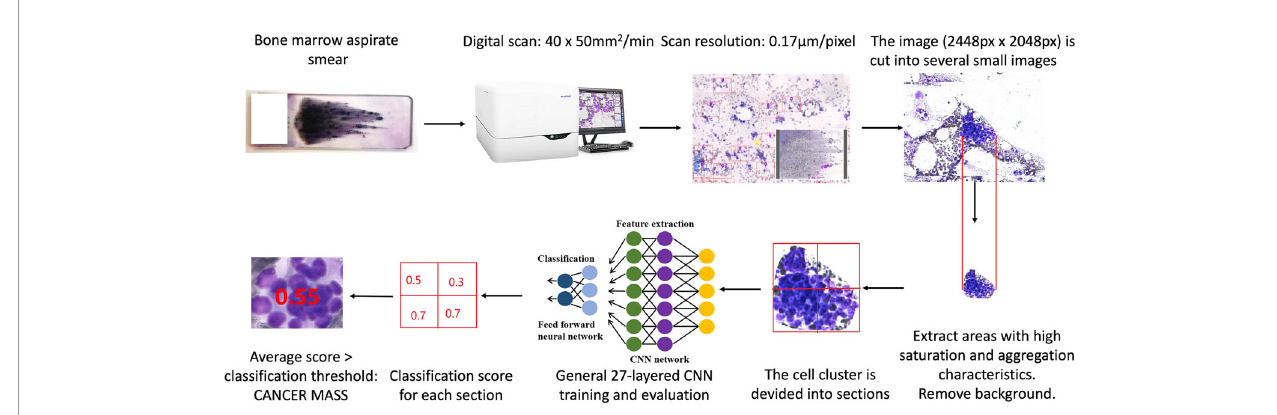
FIGURE 1 | The work fl ow of identi fi cation metastatic atypical cancer cell clusters by Morphogo in bone marrow